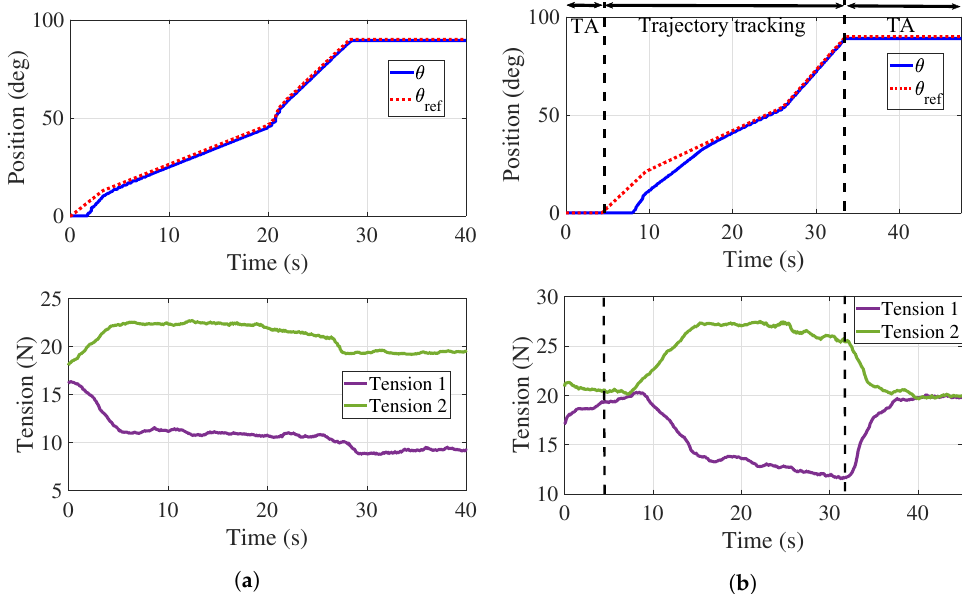
Figure 7. Trajectory tracking and tension control. ( a ) Position control without tension adjustment. ( b ) Position control with tension